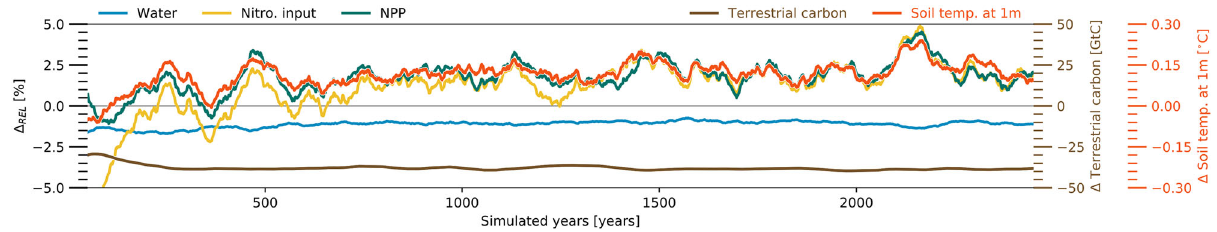
Fig. 6 Long-term effects of an temperature overshoot on the high-latitude water-, energy-, and carbon cycle. Differences between simulations initialized with the soil carbon concentrations after (P2100) and before (NoOS) an temperature overshoot (OS) that persist under nontransient atmospheric conditions (PACT1.5). Shown are relative differences in total soil water content (blue line; left y -axis), inputs of mineral nitrogen (yellow line; left y -axis) and net primary productivity (green line; left y -axis) as well as absolute differences in total terrestrial carbon (soil organic matter and vegetation biomass; brown line; right y -axis) and MJJASO temperatures at a depth of 1 m (red line; right y -axis). With respect to soil water, nitrogen inputs, productivity, and temperature the fi gure shows the average over the permafrost-affected regions, while the terrestrial carbon is an accumulated value. The simulations were initialized with different carbon pools and different states of the vegetation, but they started from the same initial conditions with respect to the system ’ s physical state (NoOS). Hence, the differences indicate only the indirect effects of the OS. All lines show 100-year-running means. It should be noted that in individual grid cells, the simulations may not have reached a steady state within the investigated time-span of 2500 years (see Fig. 4), but when averaged over the entire permafrost region the differences between the simulations stabilize after roughly 1000 years, providing an order-of-magnitude estimate of the consequences of a temporary warming that are irreversible under nontransient